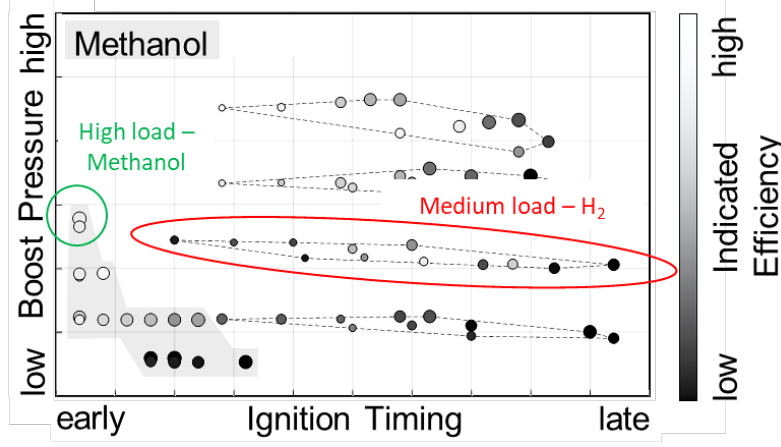
Figure 4. Operating ranges and transition between methanol and hydrogen operation